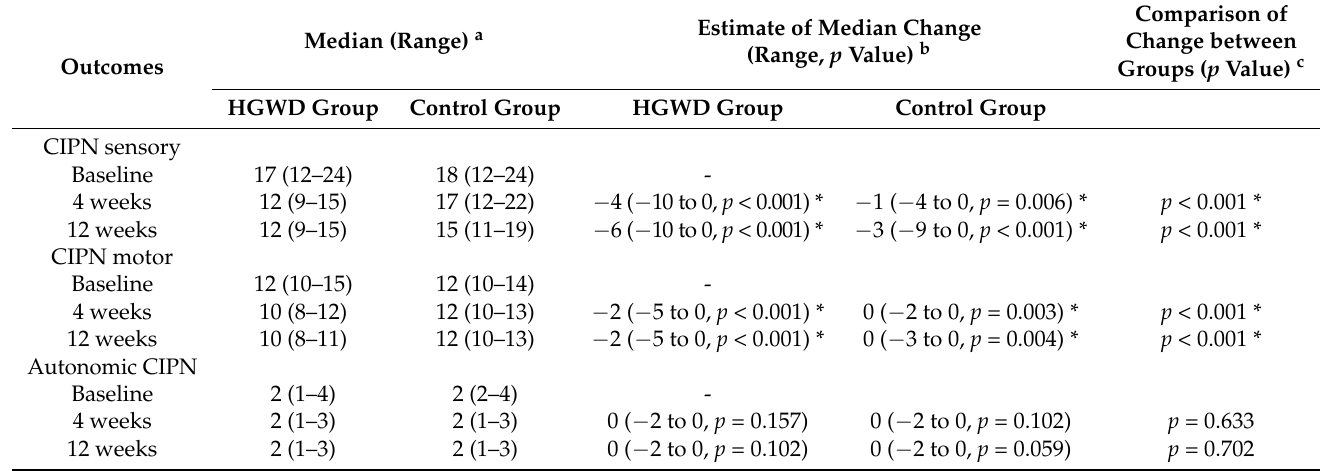
Table 2. Median (range) EORTC QLQ-CIPN20 scores for primary outcomes of HGWD group and control